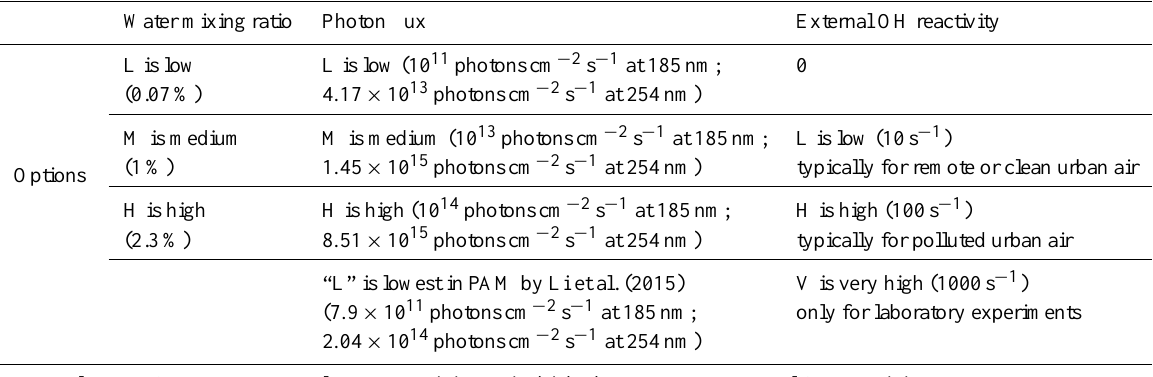
Table 1. Code of the labels of typical cases. A case label is composed of three characters denoting the water mixing ratio, the photon flux, and the external OH reactivity,